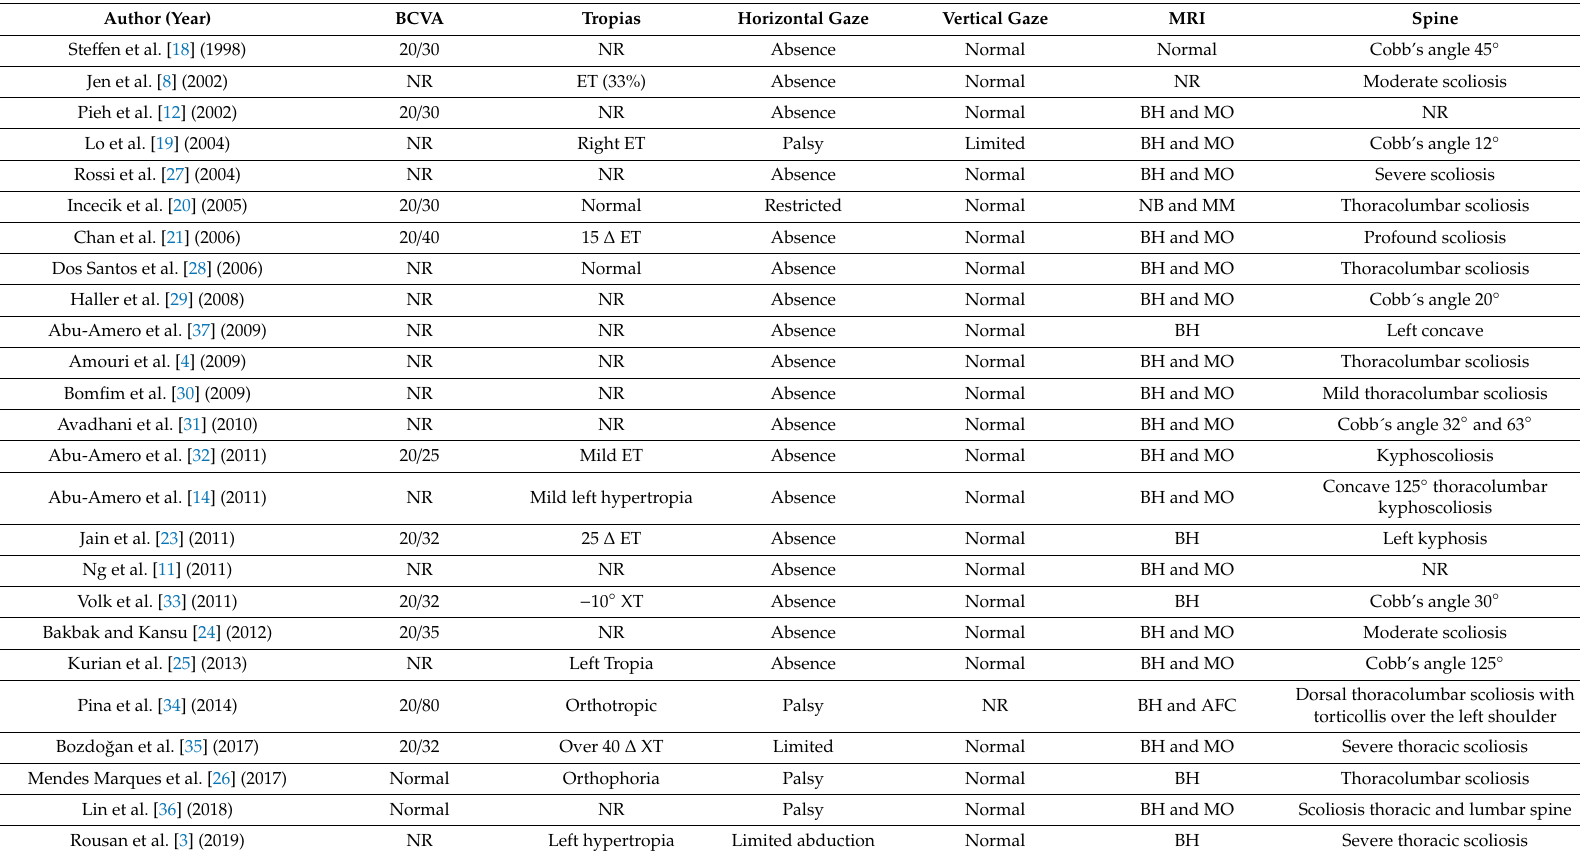
Table 2. Revised studies about horizontal gaze palsy with progressive